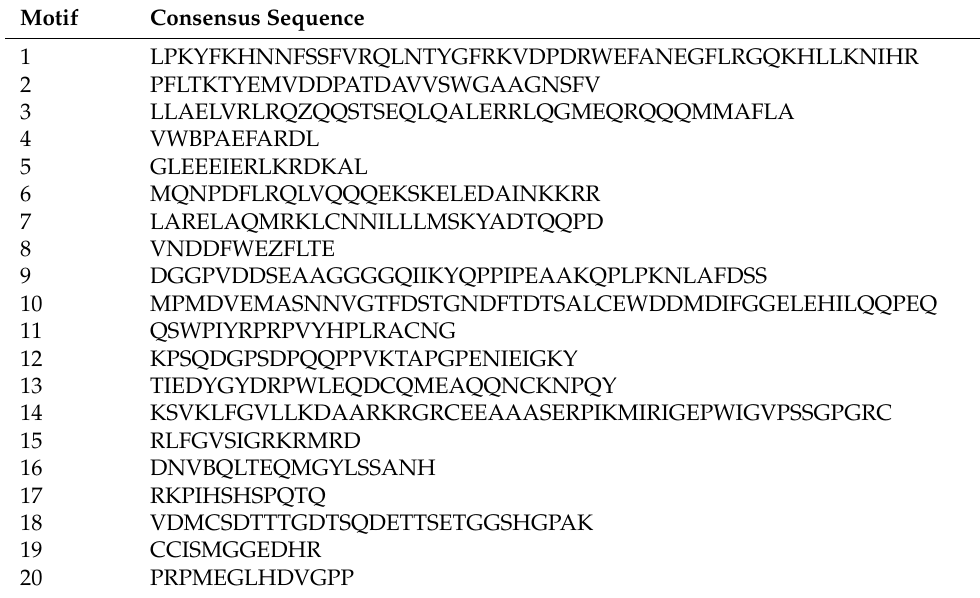
Figure 5. Conserved motifs in maize HSFs as identified by MEME. The motifs were identified by using full-length protein sequences of Zm HSFs. Name of HSFs and p-values are indicated on the left side. Each motif is represented by a unique color, as indicated at the bottom. Table 4. Conserved motif sequence of Zea mays HSFs.